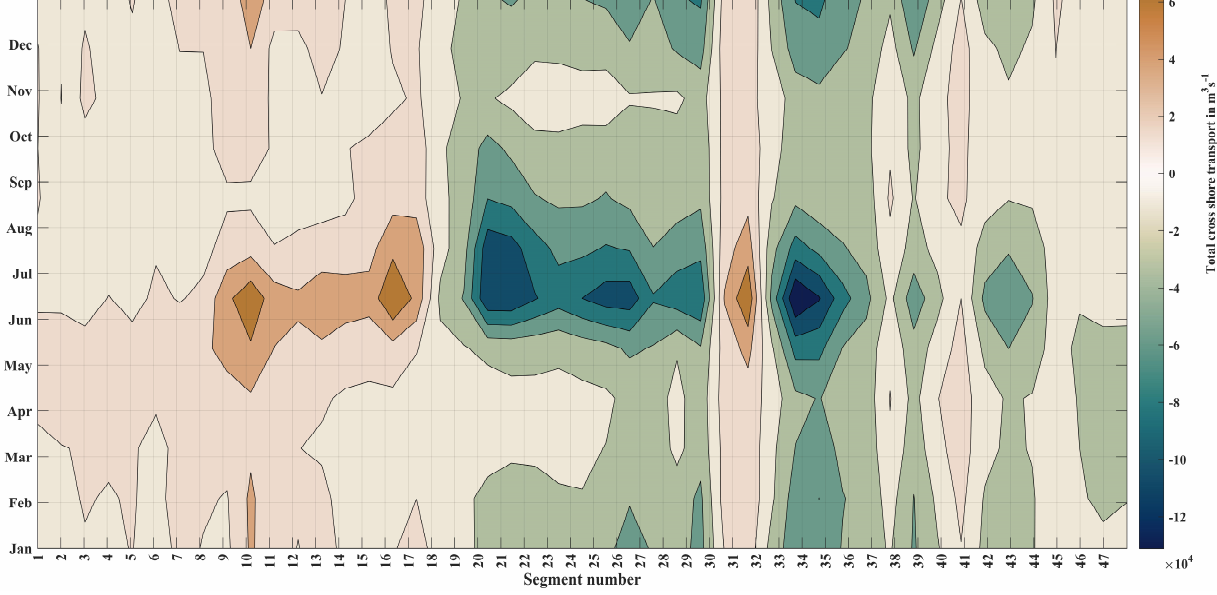
Figure 7. Annual cycles of UI total , calculated for 1993 − 2020. The UI total values are positive (corresponding to upwelling) and negative (corre- sponding to downwelling). However, the segments in some regions are more significant. Segments 10 (around 51.5 ◦ E and 28 ◦ N ) , 16–17 (around 49 ◦ E and 30 ◦ N ) , and 31–32 (around 51 ◦ E and 26 ◦ N ) , have the most intense coastal upwelling. The coastal upwelling occurred with different intensities over a year at these segments, but there is a peak in June. By distancing from these segments or the peak, spatially or temporally, the positive value of 𝑈𝐼 (cid:3047)(cid:3042)(cid:3047)(cid:3028)(cid:3039) decreases and the intensity of coastal upwelling reduces. In addition, 𝑈𝐼 (cid:3047)(cid:3042)(cid:3047)(cid:3028)(cid:3039) values are negative in some segments. However, the segments in some regions are more signi fi cant. Segments 20–22 (around 48 ° E and 29 ° N (cid:3398) 49 ° E and 28 ° N (cid:4667) , 26–27 (around 50 ° E and 26 ° N (cid:4667) , and spatially, 33–35 (around 51.5 ° E and 26 ° N (cid:3398) 51.5 ° E and 25 ° N (cid:4667) , have the most intense downwelling. According to Figures 5 and 7, the total cross-shore transport pa tt ern is very similar to the 𝐶𝑈𝐼 (cid:3032)(cid:3038)(cid:3040)(cid:3028)(cid:3041) in terms of spatial and temporal structure, and it accurately identi fi es the same segments as active upwelling and downwelling regions and shows the same favor- able time conditions for the formation of these phenomena. Therefore, the Ekman transport is the dominant component in the total cross-shore transport, which can accu- rately determine the structure of active upwelling and downwelling in the Persian Gulf, but the geostrophic transport a ff ects the intensity of upwelling and downwelling. According to Figure 4, the maximum value of the 𝐶𝑈𝐼 (cid:3032)(cid:3038)(cid:3040)(cid:3028)(cid:3041) is about 0.8 × 10 5 m (cid:2871) s (cid:2879)(cid:2869) in segments 10, 19, and 32, but the maximum value of the 𝑈𝐼 (cid:3047)(cid:3042)(cid:3047)(cid:3028)(cid:3039) decreases to about 6 × 10 4 m (cid:2871) s (cid:2879)(cid:2869) in these segments, which shows that the intensity of upwelling decreases by considering the geostrophic transition in the upwelling/downwelling index. Additionally, the maximum absolute value of 𝑇 (cid:3034)(cid:3032)(cid:3042) is about 1 × 10 5 m (cid:2871) s (cid:2879)(cid:2869) in segments 10, 19, and 32, while the maximum absolute value of 𝑈𝐼 (cid:3047)(cid:3042)(cid:3047)(cid:3028)(cid:3039) increases to about 12 × 10 4 m (cid:2871) s (cid:2879)(cid:2869) in these segments, which indicates that the intensity of downwelling increases by considering the geostrophic transport in the upwelling/downwelling index in these areas. In other words, with the algebraic sum of geostrophic and Ekman transport, the intensity of the coastal upwelling decreases, and the intensity of the coastal downwelling increases in the favored spatial and temporal conditions in the Persian Gulf.